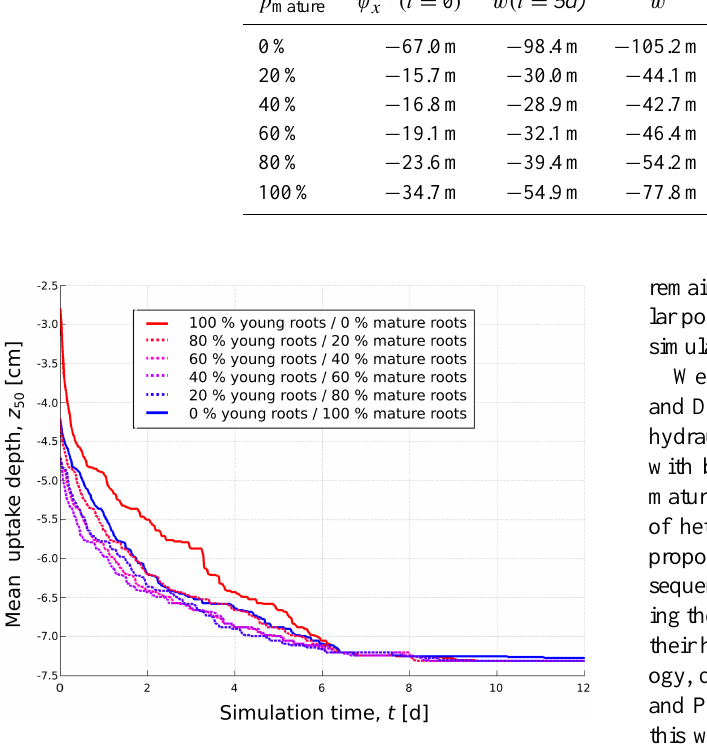
Figure 9. Temporal evolution of mean uptake depth z 50 in the fixed root geometry for the six different hydraulic parameterizations. Re- sults are obtained with the “aRoot” model for proportions of young roots between 0 and 100%. Homogeneous root systems are de- picted in solid lines; heterogeneous root systems are depicted with dashed